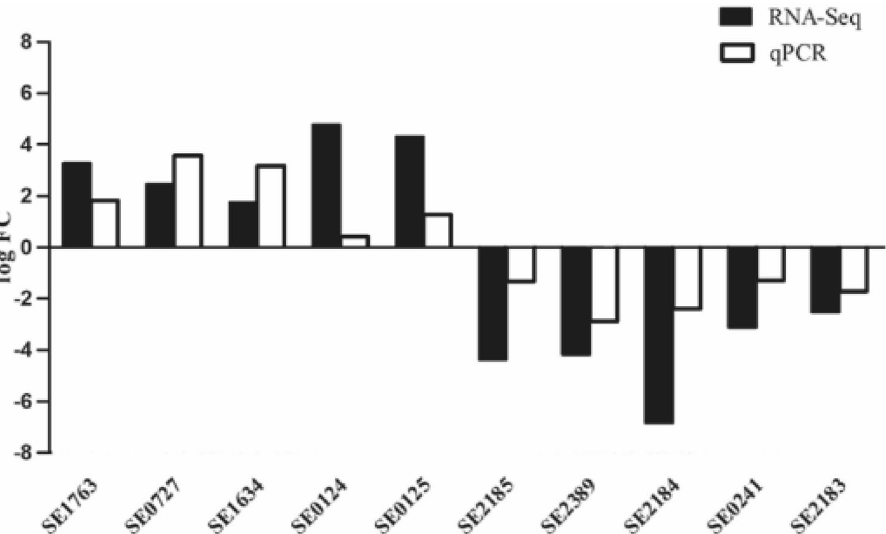
Figure 4. Comparison of the log2 fold change (log FC) of ten randomly selected differentially expressed genes between RNA-Seq and qRT-PCR. The results indicated that the qRT-PCR data were consistent with the results of